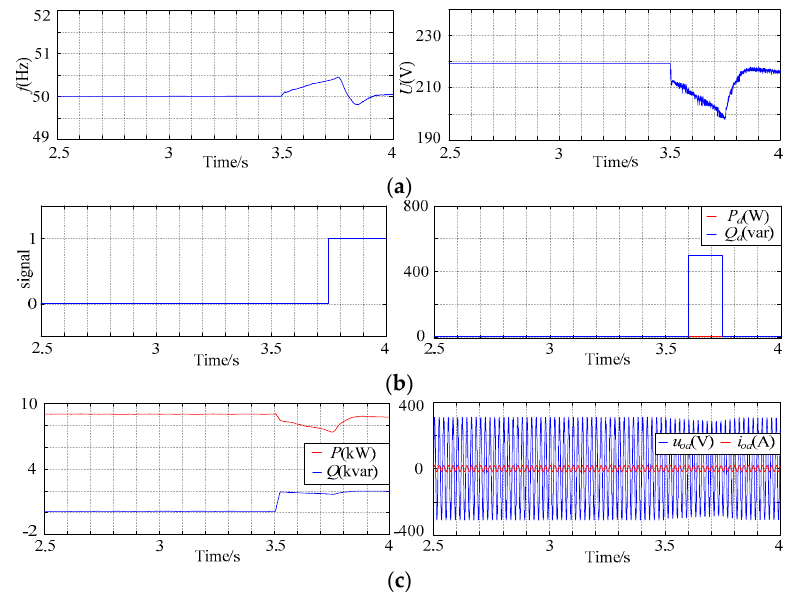
Figure 13. The process of islanding detection when reactive power unbalanced: ( a ) The output voltage frequency and ampitude of the inverter; ( b ) The signal of islanding detection and the power disturbance; ( c ) The output power and the A phase voltage and current of inverter.